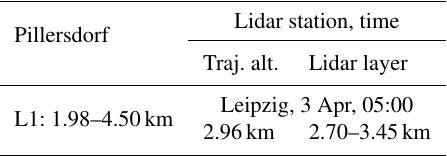
Table 4. Association of layers from lidar measurements with layers and trajectories computed for Pillersdorf, 4 April 2014, 12:00. Pillersdorf